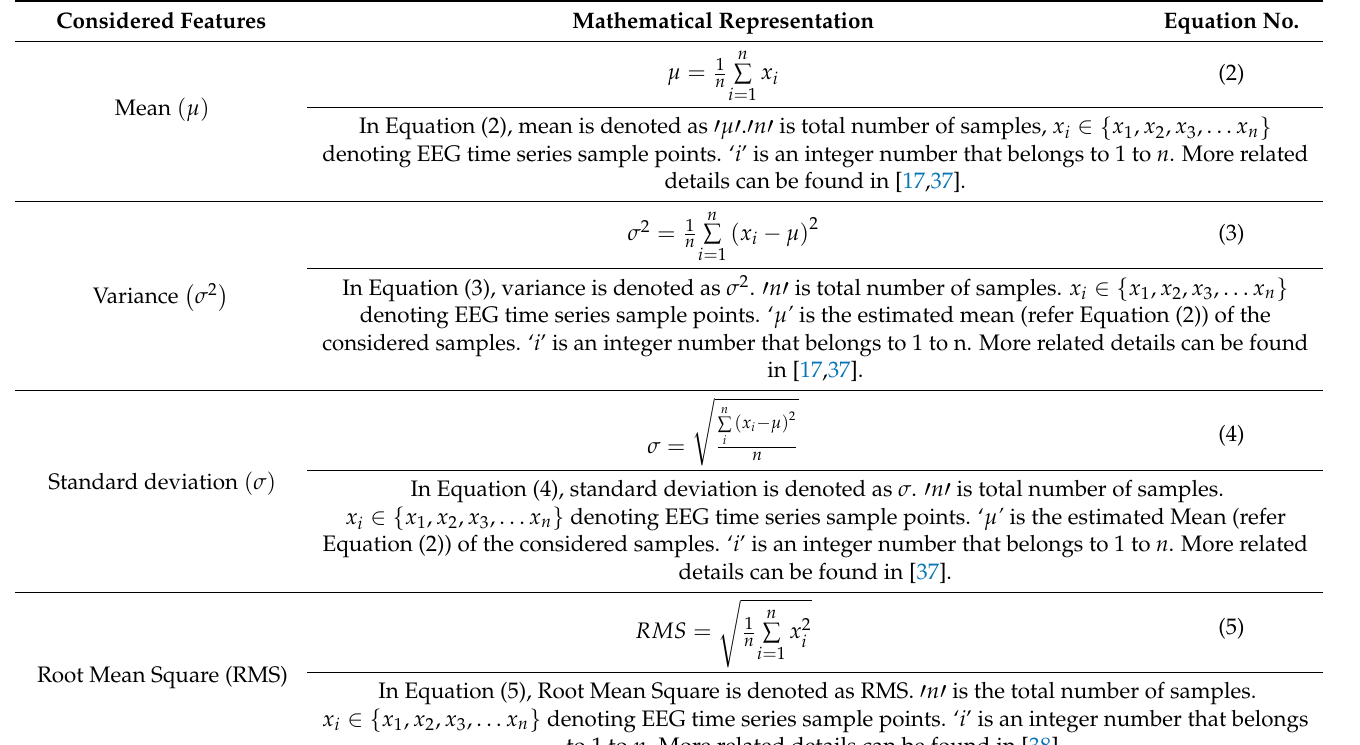
Table 1. Mathematical formula of considered